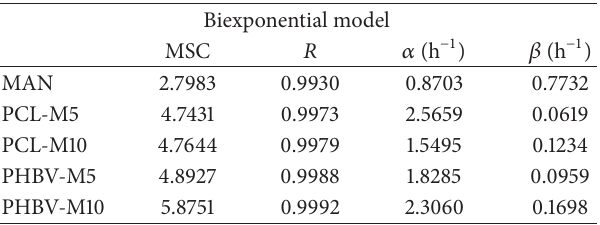
Table 5: Release data from MAN and MAN-loaded